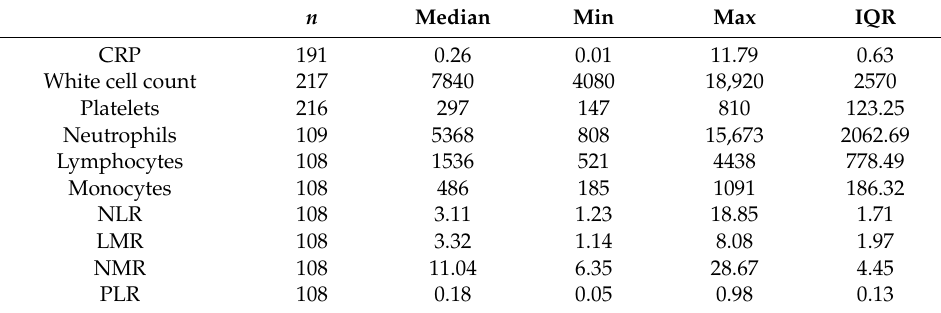
Table 3. Baseline blood